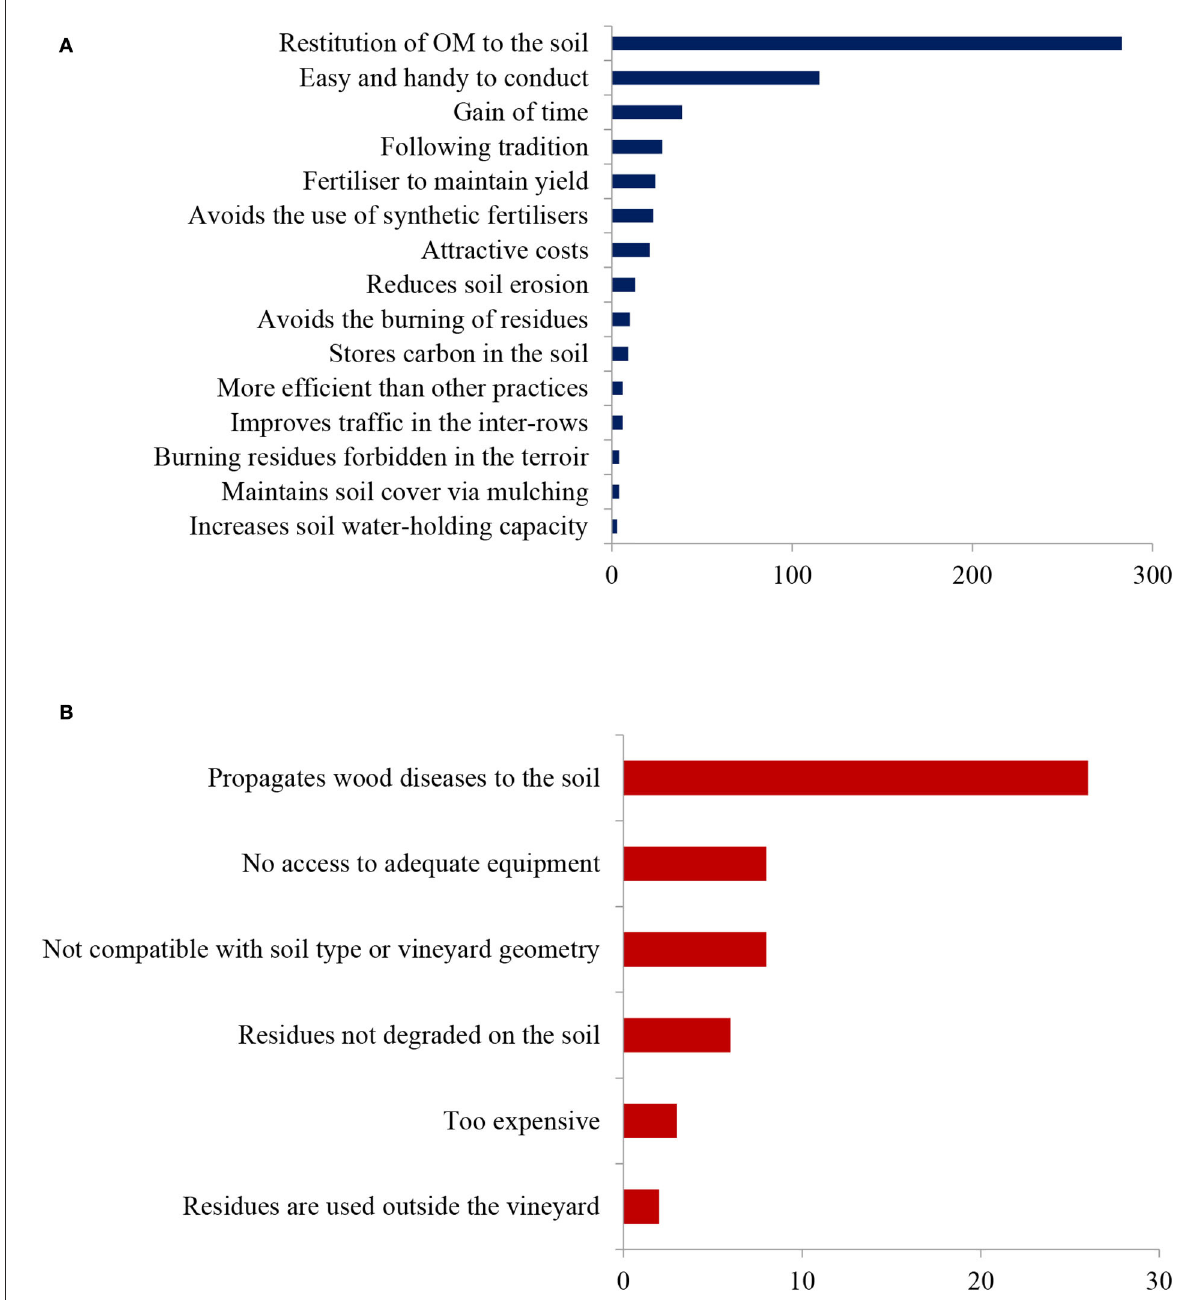
FIGURE3 Motives (A) and barriers (B) to returning pruning residues to the soil in viticulture in France ( n = 421 and 42, respectively). Several responses were possible for each respondent. OM, organic